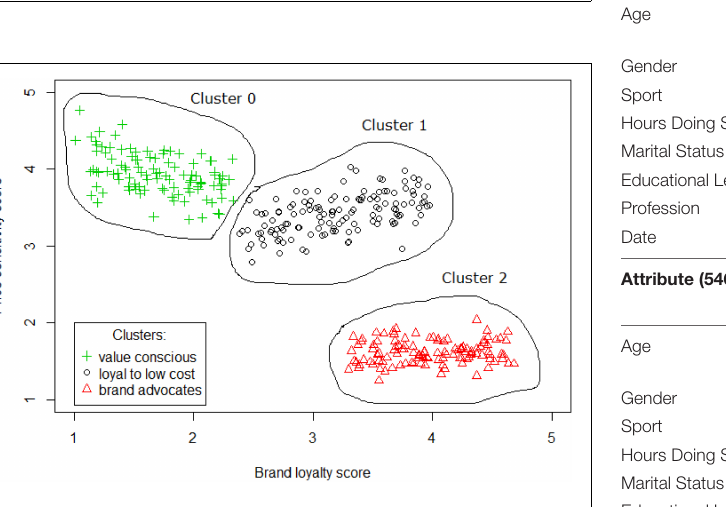
FIGURE 4 | Customers clustering based on their sensitivity to price and brand